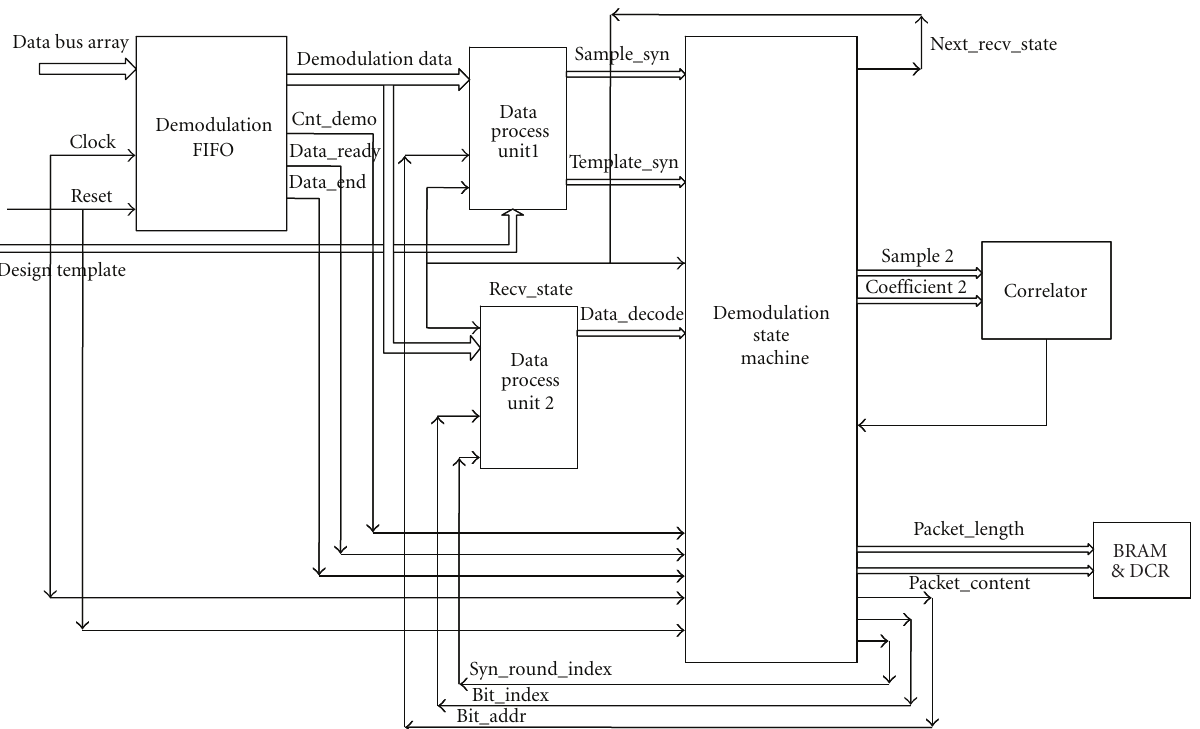
Figure 7: Demodulation unit internal